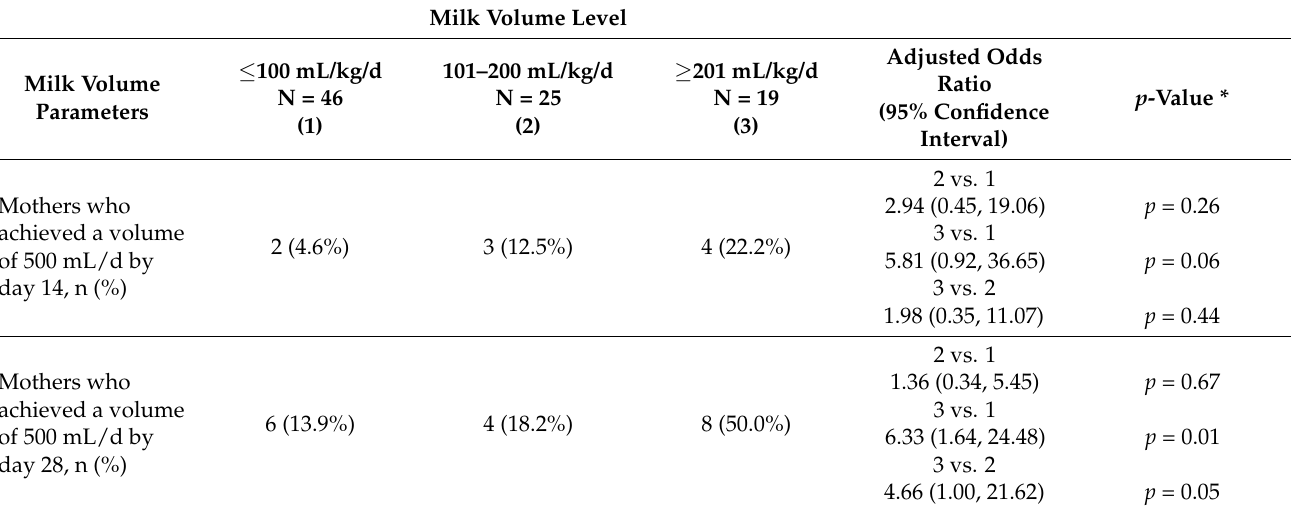
Table 5. Secondary outcome: proportion of mothers who achieved 500 mL/day by days 14 and 28 of study